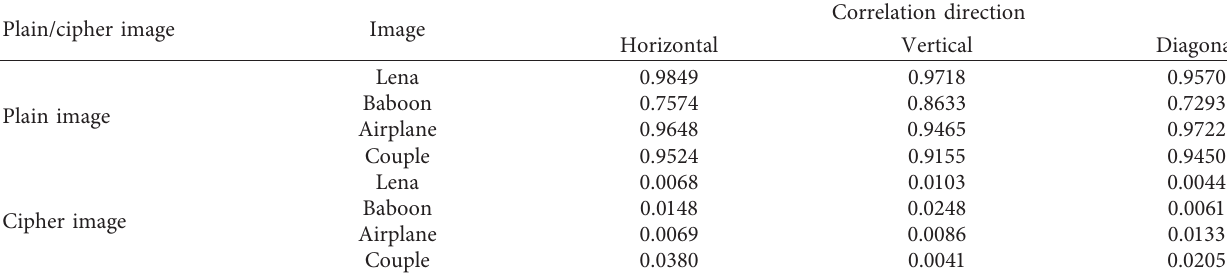
Table 2: Correlation coefficients between the original and cipher